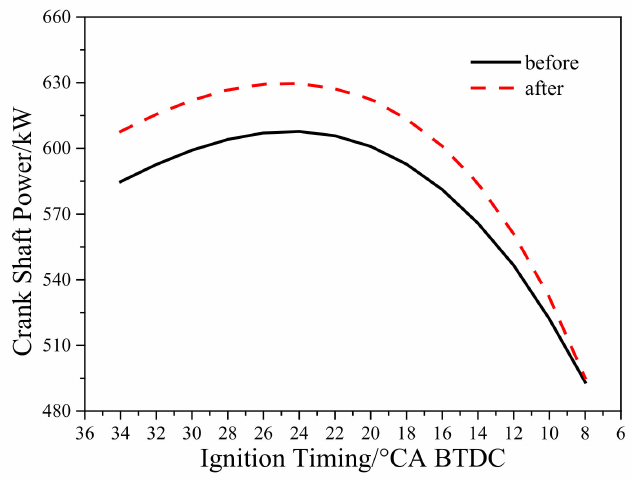
Figure 16. Comparison of crankshaft power before and after